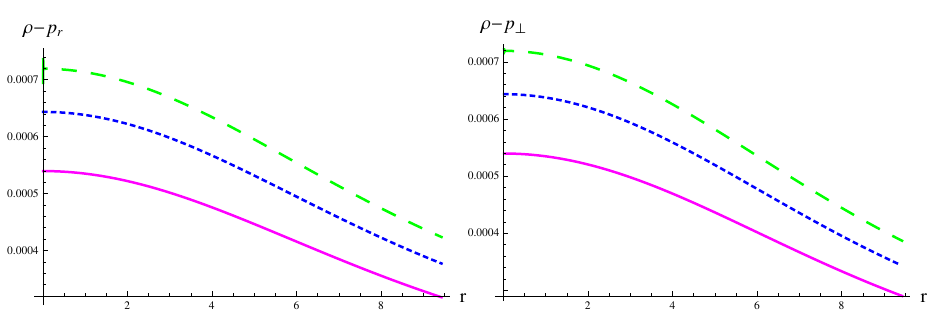
Figure 4. DEC for extended solution I for Υ = 0.2.